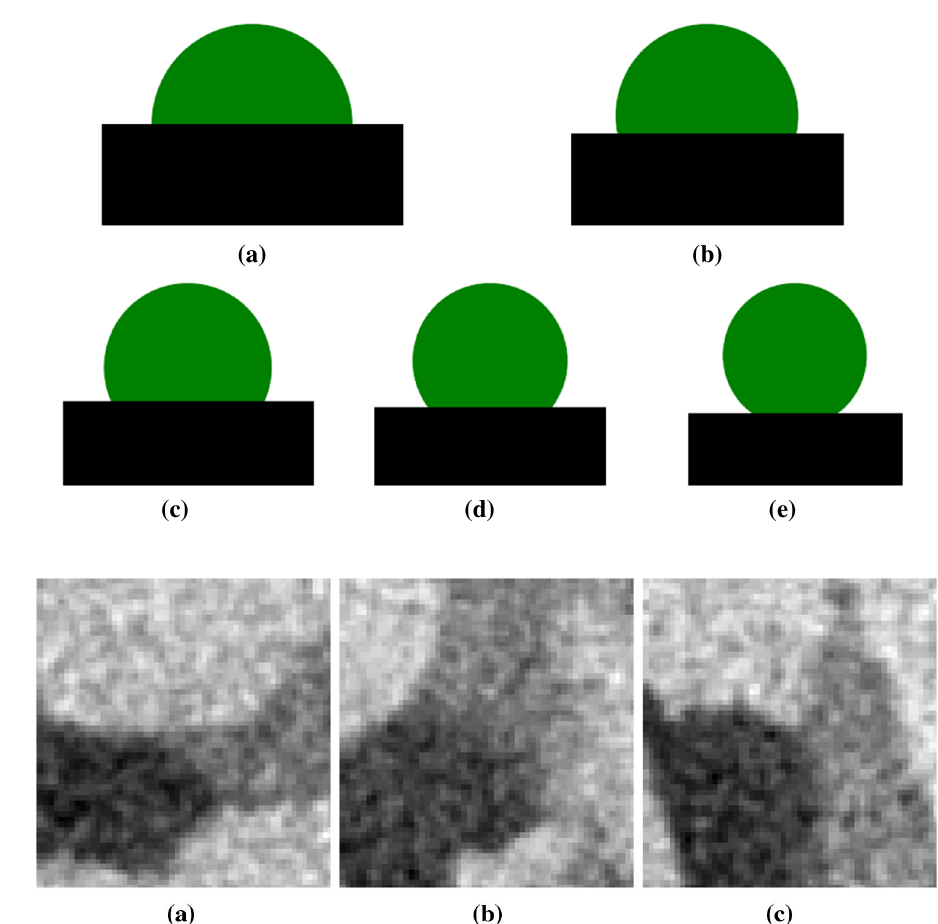
Fig. 3 Analytically generated images, with green being the oil droplet, black being the rock, and white being the brine